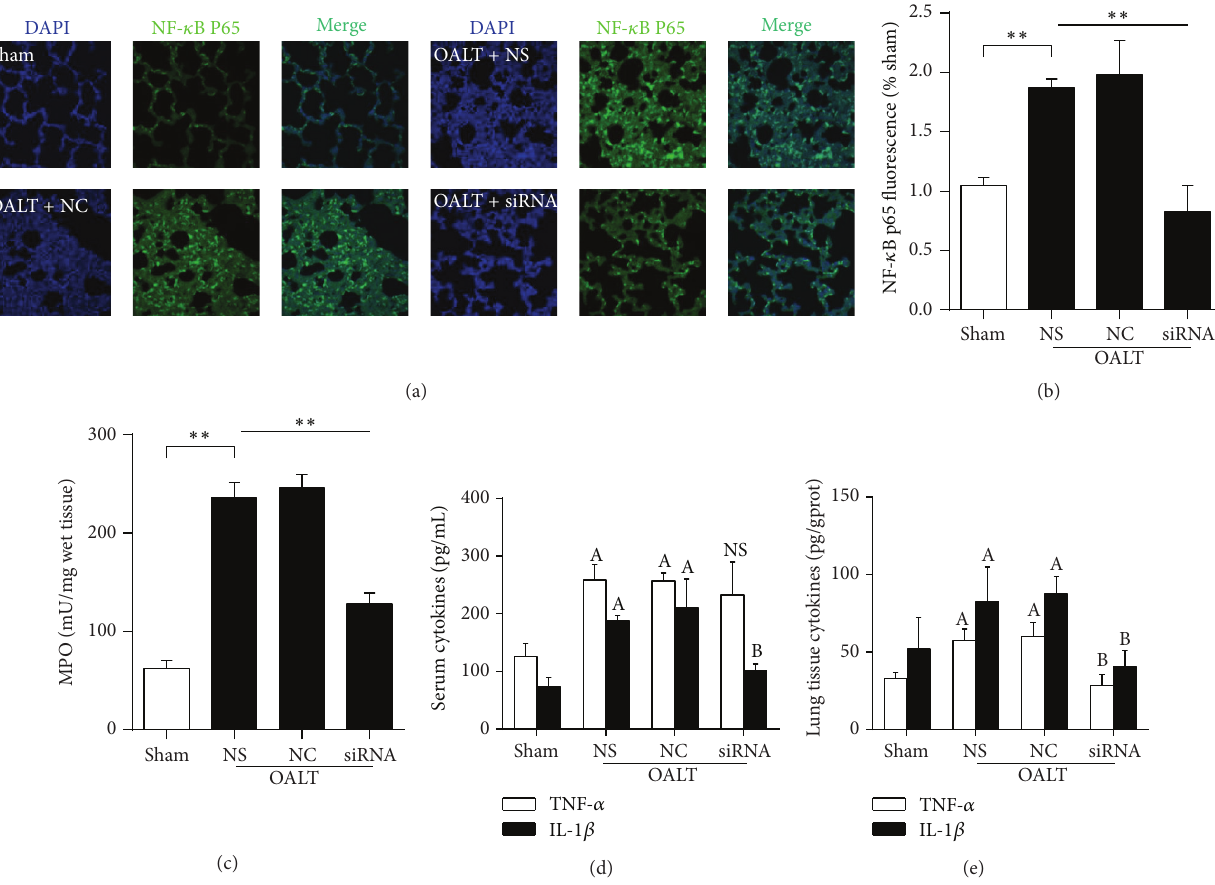
Figure 4: TLR4/NF- 𝜅 B P65 pathway was activated in injured lung following OALT. (a) and (b) showed immunofluorescent assay of NF- 𝜅 B P65 in lung tissue. (c) showed MPO activity in lung tissue. (d) and (e) showed TNF- 𝛼 and IL-1 𝛽 concentration in serum and lung tissue, respectively. Groups S, NS, NC, and siRNA were treated with nothing, saline, negative control siRNA, and targeting siRNA, respectively. Values were expressed as mean ± SEM. ∗ 𝑃 < 0.0 , ∗∗ 𝑃 < 0.01 , A 𝑃 < 0.05 versus Group S, B 𝑃 < 0.05 versus Group NC, NS means no significant difference versus Group NC, one-way ANOVA with Tukey